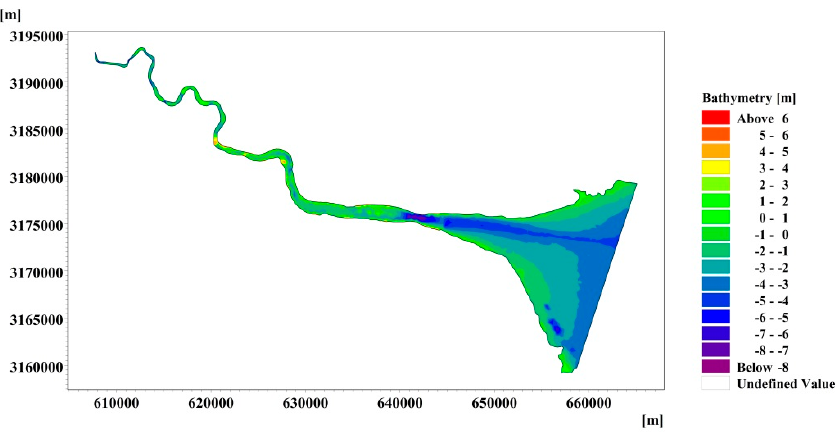
Figure 2. Bathymetry of the calibration